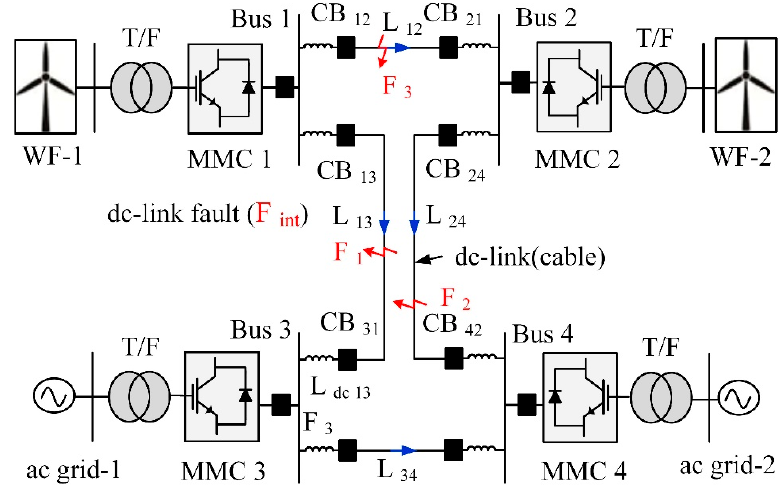
Figure 5. Configuration of MMC-based dc grid. Table 2. Converter parameters .